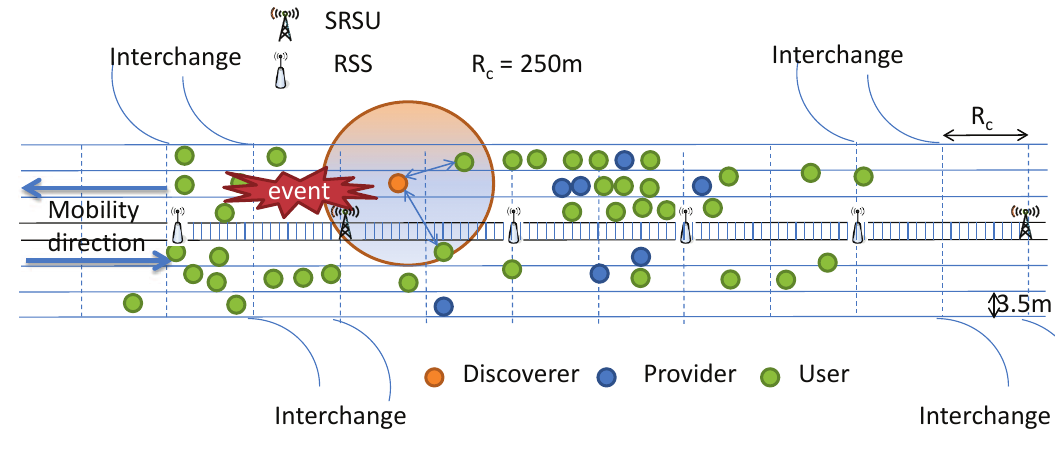
Figure 5. Example of event broadcasting